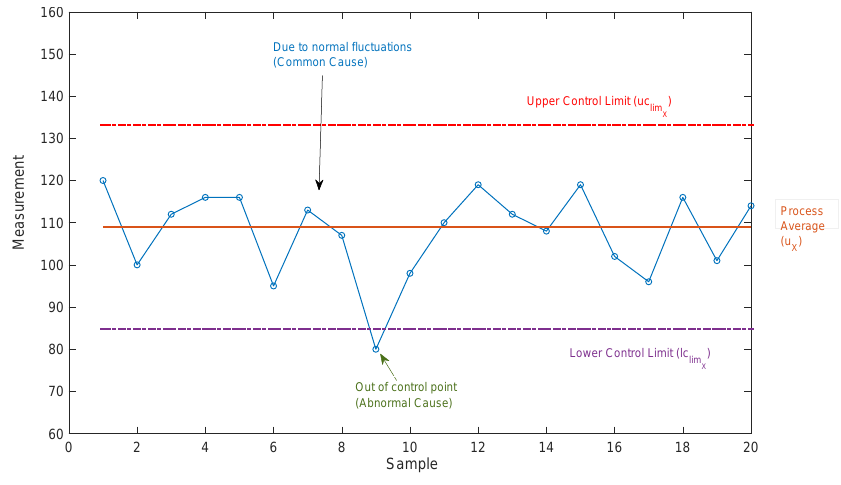
Figure 5. CC of the output of a process [34].